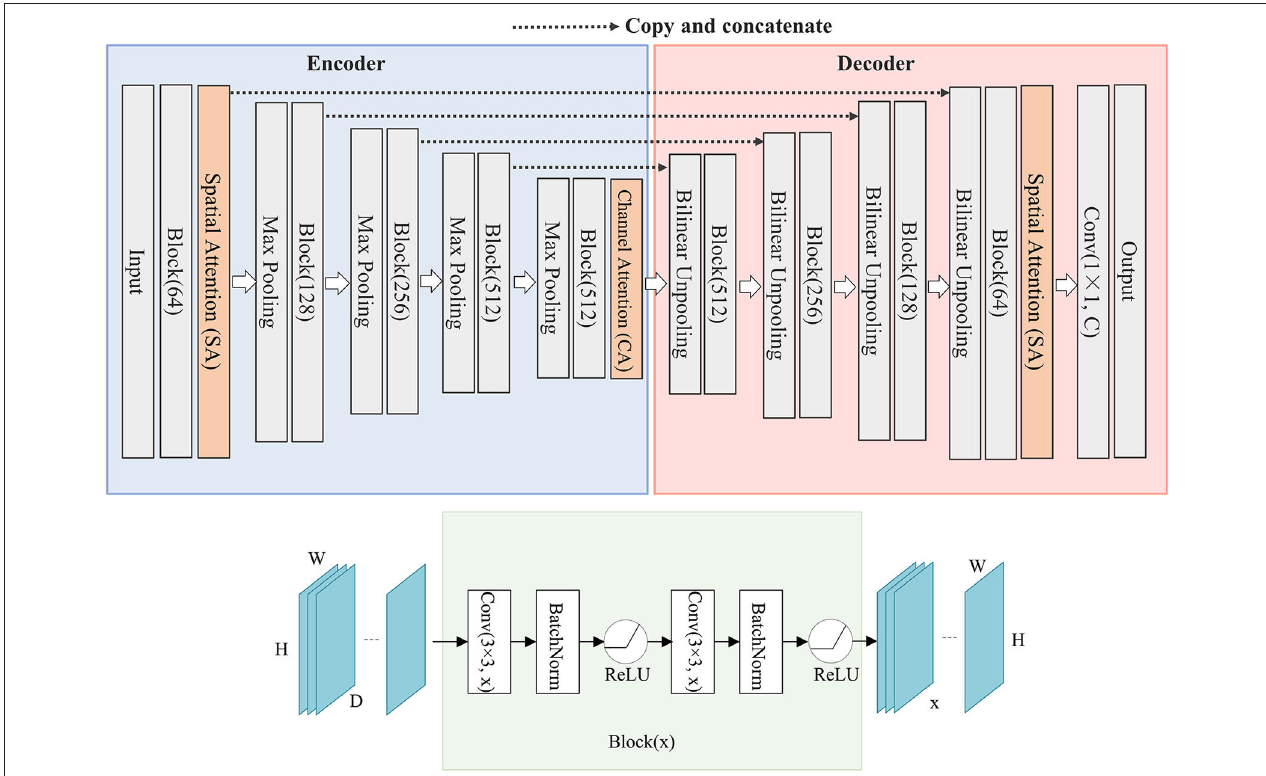
FIGURE 1 | The structure of SCAU-Net. The entire structure is divided into four parts: encoder, decoder, spatial attention module, channel attention module. Given an input feature map of size D × H × W, the output size of Block(x) is x × H × W. W, width; H, height of feature map; D, input channel number; x, output channel number.